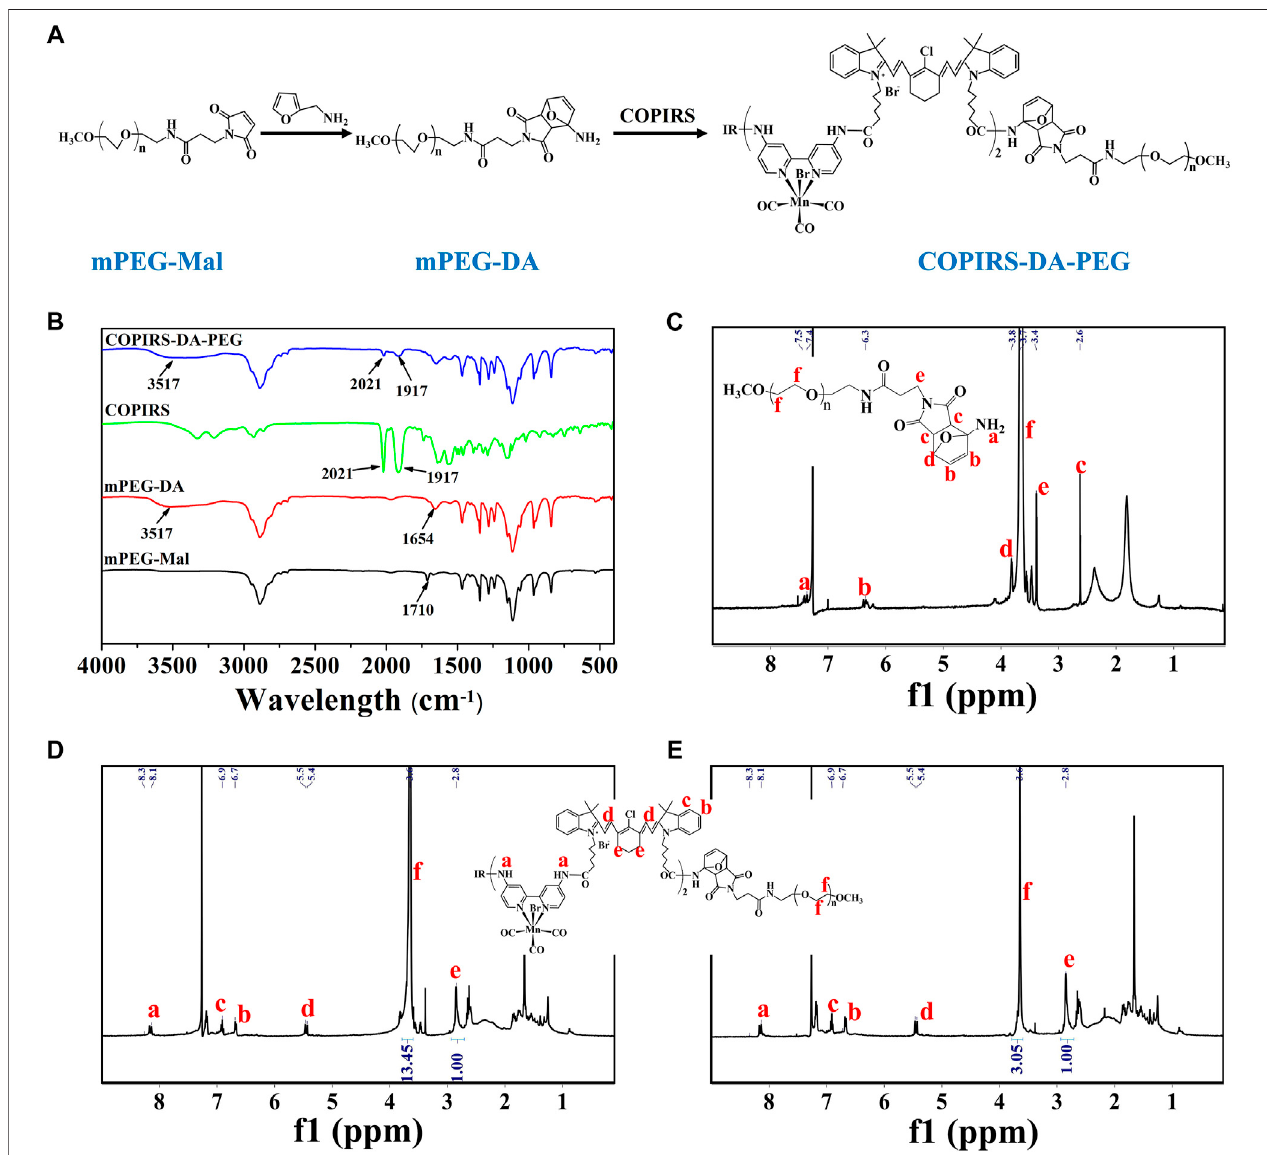
FIGURE 3 | Characterization of COPIRS-DA-PEG. (A) The synthetic route of COPIRS-DA-PEG. n ≈ 41; (B) FT-IR spectra of mPEG-Mal, mPEG-DA, COPIRS, and COPIRS-DA-PEG; (C) 1 H-NMR spectrum of mPEG-DA; (D) 1 H-NMR spectrum of COPIRS-DA-PEG; (E) 1 H-NMR spectrum of COPIRS-DA-PEG after incubation at 65 ° C and dialysis.